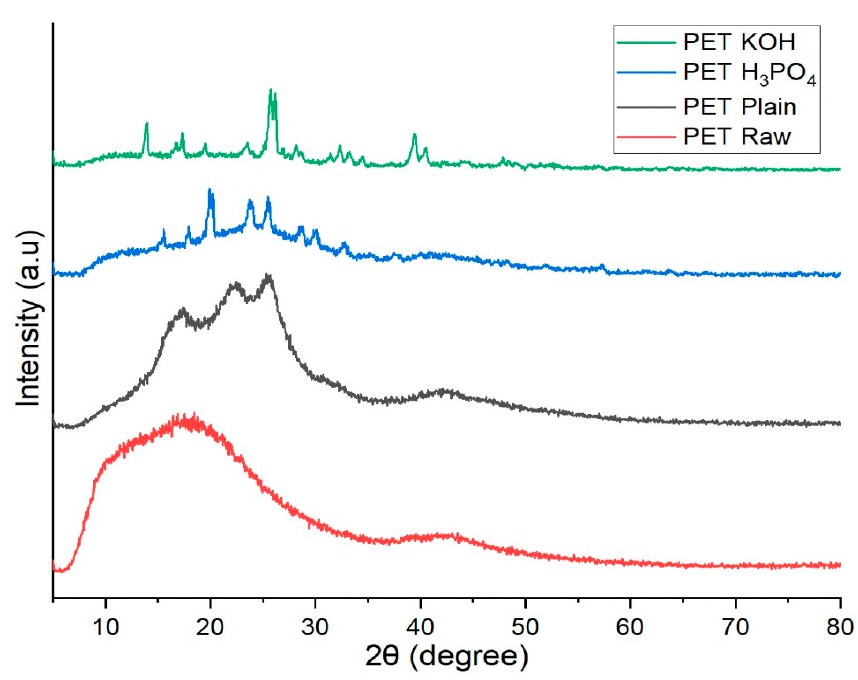
Figure 5. X-ray diffraction (XRD) spectra of PET Raw, PET Plain, PET H 3 PO 4 and PET KOH.